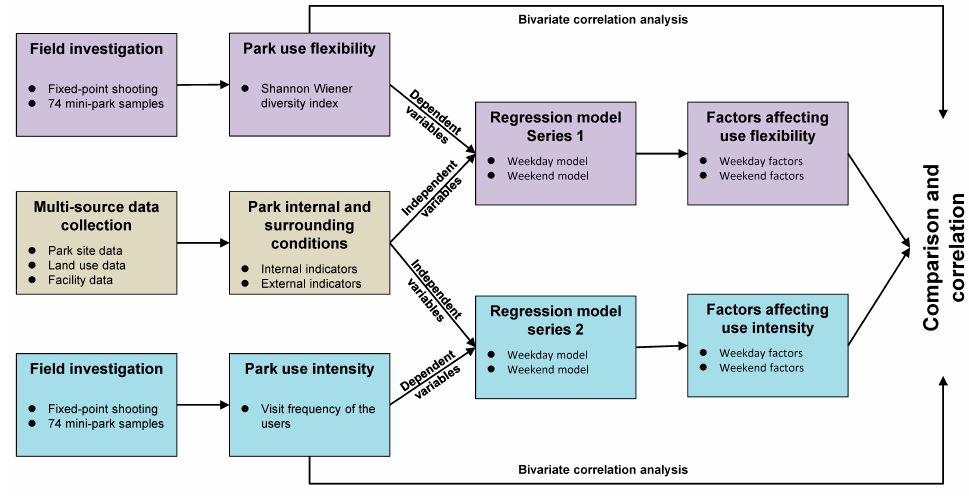
Figure 3. Modeling roadmap.